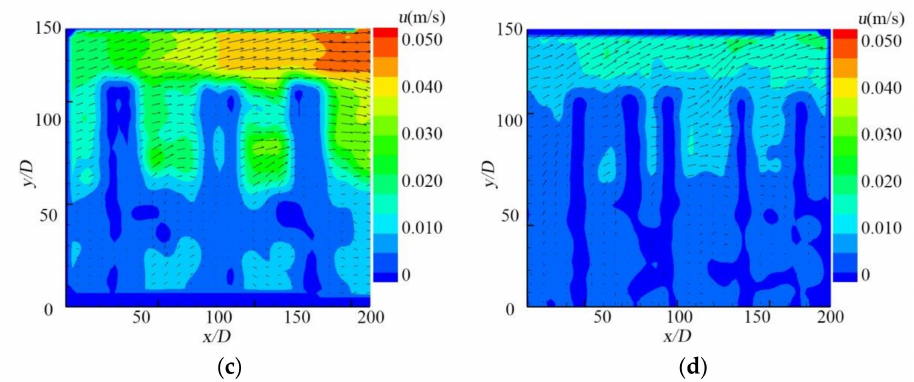
Figure 5. The average flow field distribution of a longitudinal section y / D = 10 under the action of vegetation. ( a ) vector map of V xz for run V0J1; ( b ) vector map of V xz for run V1J1; ( c ) vector map of V xz for run V2J1; ( d ) vector map of V xz for run